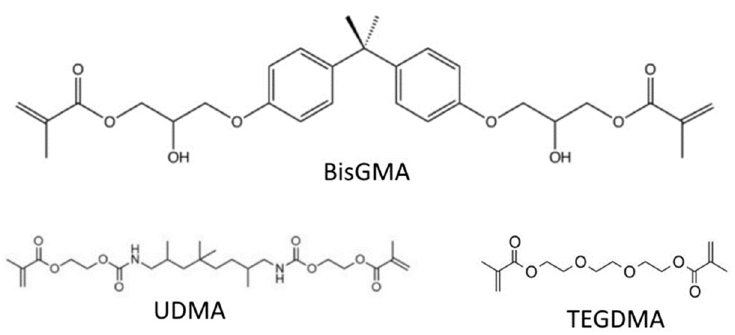
Figure 1. Common crosslinking monomers in dental resin composites.